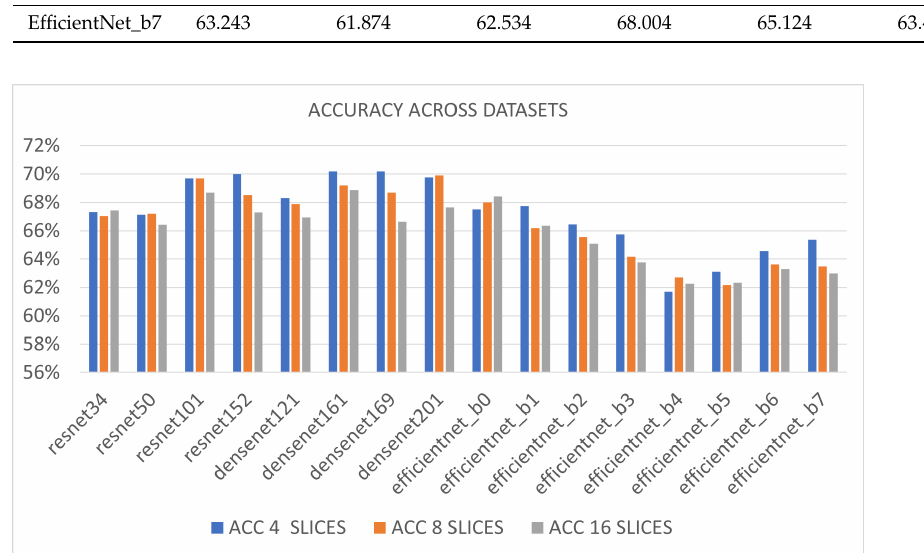
Figure 2. Accuracy across datasets of tested CNN models. The ResNet152, DenseNet161 and DenseNet169 models gathered the best scores (a few more than 70%) when 4 slices per subject were extracted (blue vertical bars). In the case of 8 slices per subject (orange vertical bars), the model that experienced the best accuracy clearly was the DenseNet201 model (mean accuracy almost 70%) whereas in the case of 16 slices per subject (grey vertical bars), the most accurate model was the DenseNet161 (mean accuracy more than 69%). Overall, all the DenseNet models provided satisfying outcomes in all three experimental cases (average accuracy across experiments and models 68.68% against EfficientNetand ResNet models reaching 64.69% and 68.03%). Satisfactory results were also reached by using deeper ResNet models and the tightest EfficientNet one. From accuracy results in Table 2, it is possible to understand that, for the considered classification problem, CNN requires representing the information on several levels of extracted features. This can be better achieved by DenseNet architectures, which make